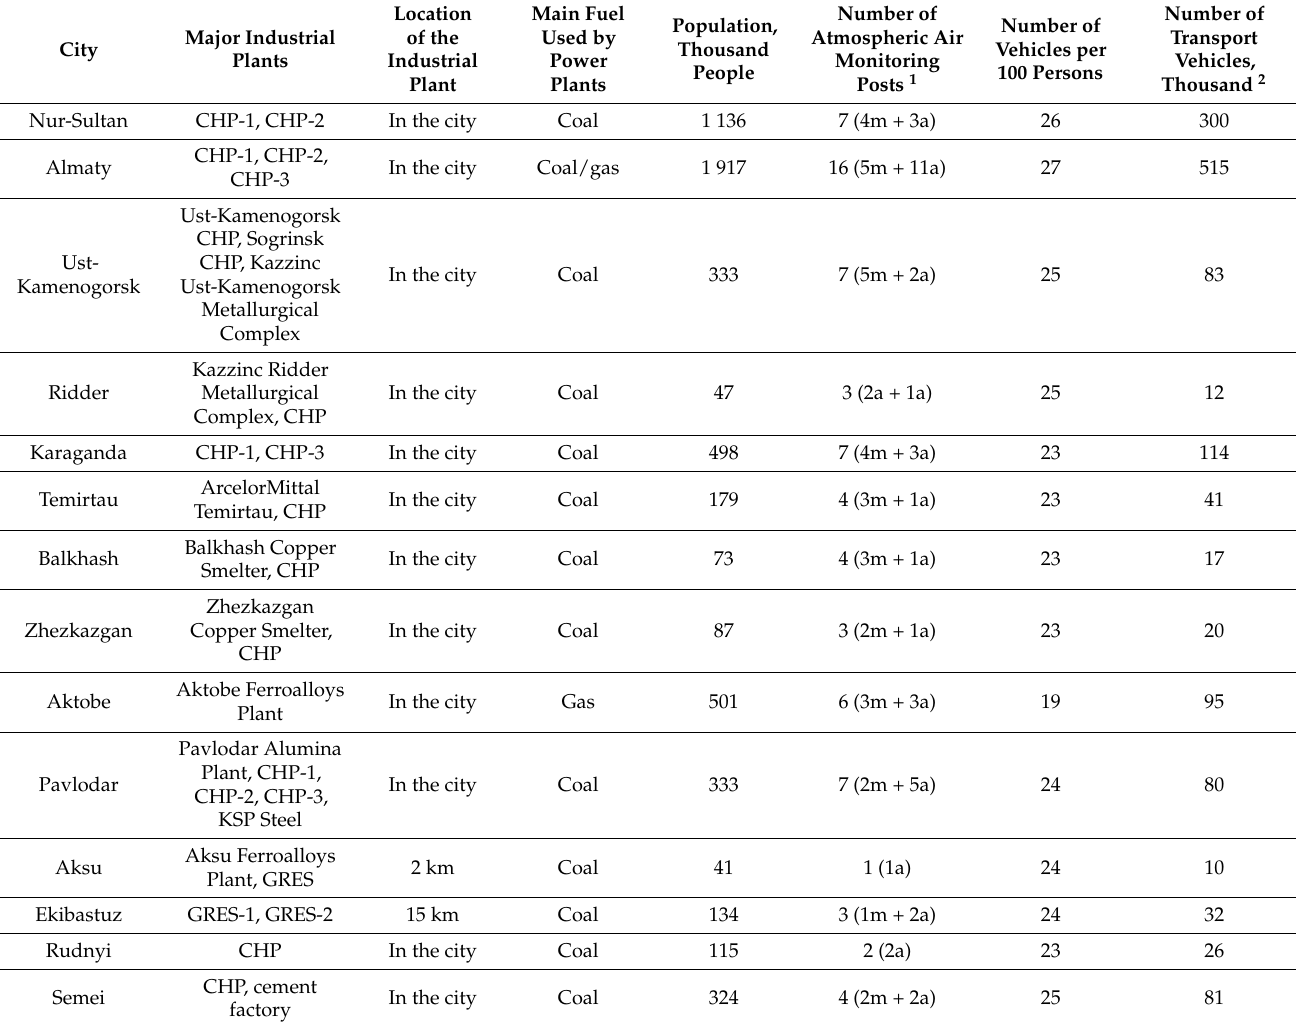
Table 3. Main characteristics of the selected industrial